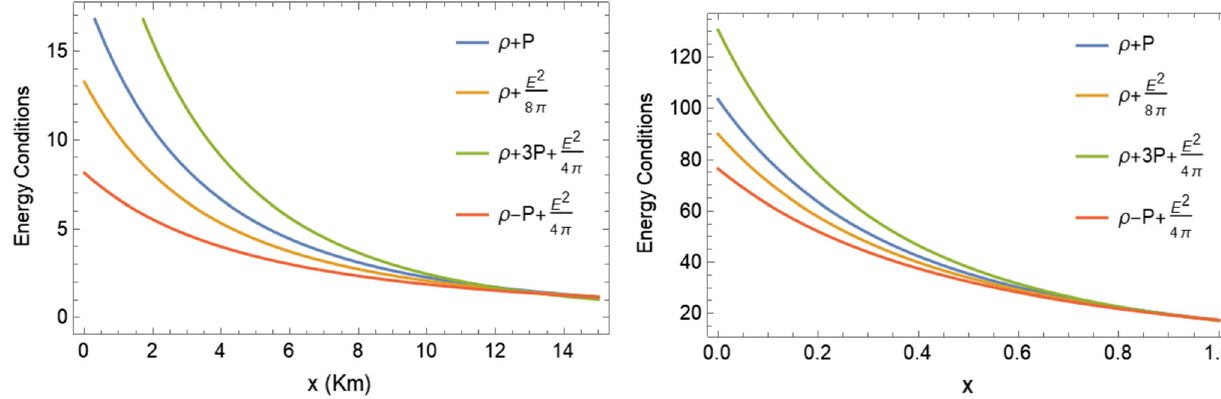
Fig. 6 Variation of energy conditions with the radial coordinate x